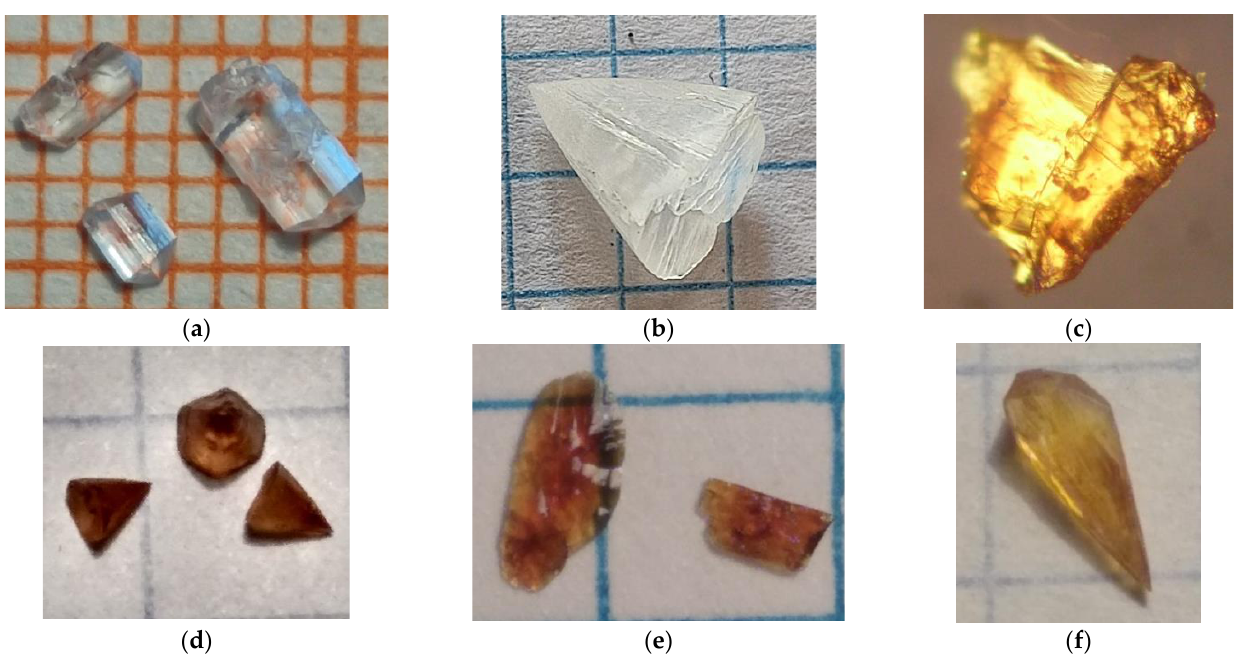
Figure 1. Images of crystals used in this research. α -Gly crystals grown from aqueous solution ( a ). γ -Gly crystal grown from aqueous solution with adding 5% of citric acid C6H8O7 ( b ). Croconic acid crystal ( c ). Gly:CA crystals grown from solutions with relative weight ratios of Gly and CA 80:20 ( d ), 90:10 ( e ), 98:2 ( f ).